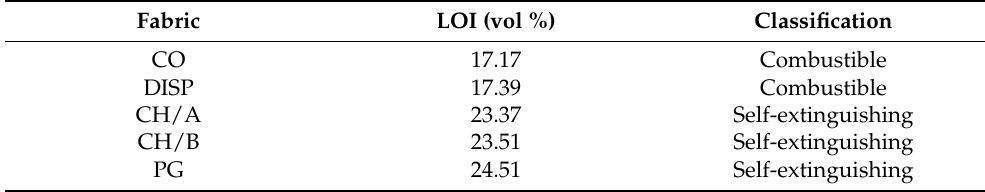
Table 2. The LOI values of fabrics.